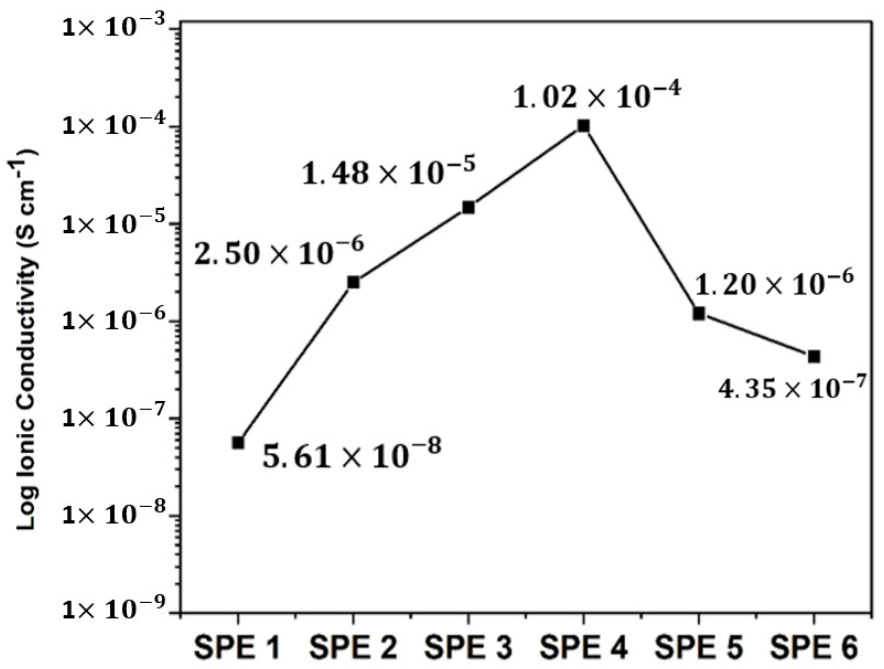
Figure 1. Ionic conductivity at various ratios of NaClO 4 .